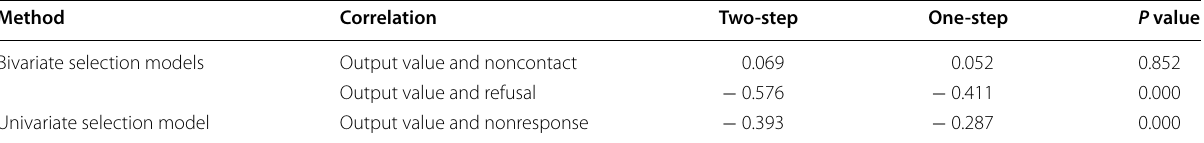
Table 7 Estimates of correlations and P values in the bivariate selection model using two-step and one-step